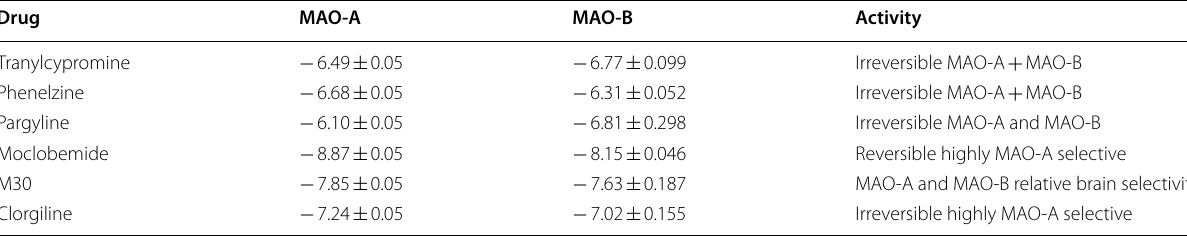
Assays were performed using Autodock VINA software, 100 independent assays. Values represent mean